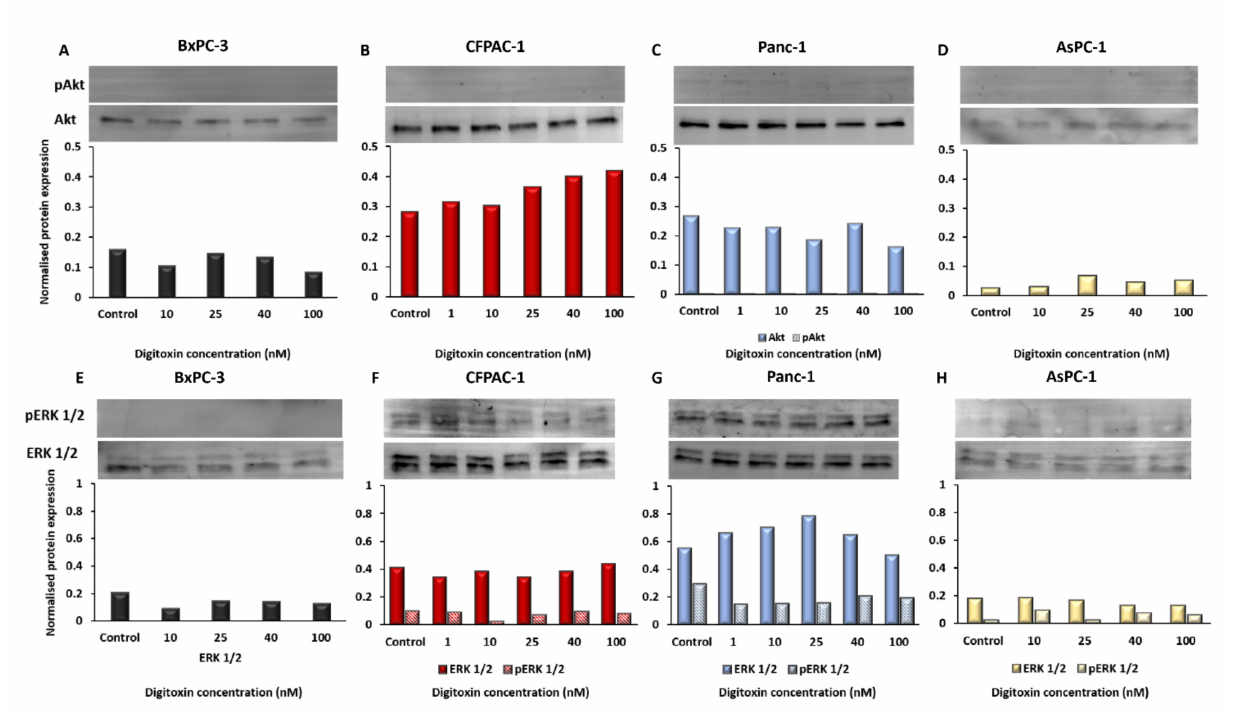
Figure 5. Protein expression of Akt, pAkt, ERK1/2, and pERK1/2 normalized to the total protein for each sample. Untreated cells (control) compared to cells treated with digitoxin for 1 − 100 nM for 48 h. In ( A , E ) BxPC-3, ( B , F ) CFPAC-1, ( C , G ) Panc-1, and ( D , H )